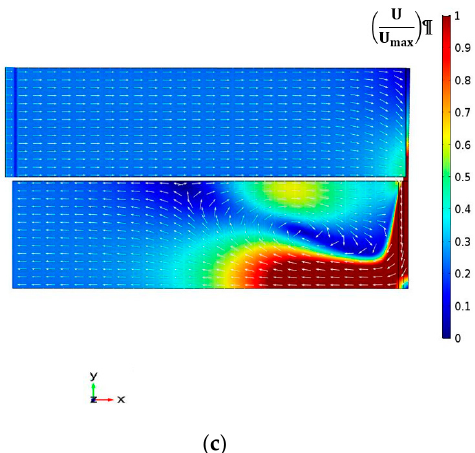
Figure 6. Velocity vector plots at a constant mass flow rate of 2.4 kg/s, slope angle of 1°, and various water depths: ( a ) 5.6 mm, ( b ) 7.5 mm, and ( c ) 10 mm.